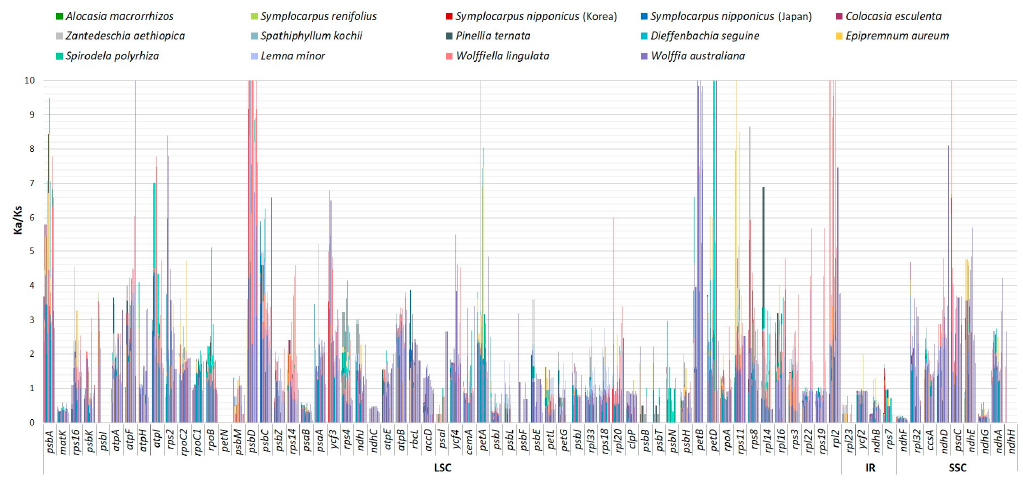
/ Ks ratio of 71 protein-coding genes of cp genomes from 14 Araceae Figure 2. The Ka/Ks ratio of 71 protein-coding genes of cp genomes from 14 Araceae species. Figure 2. The Ka